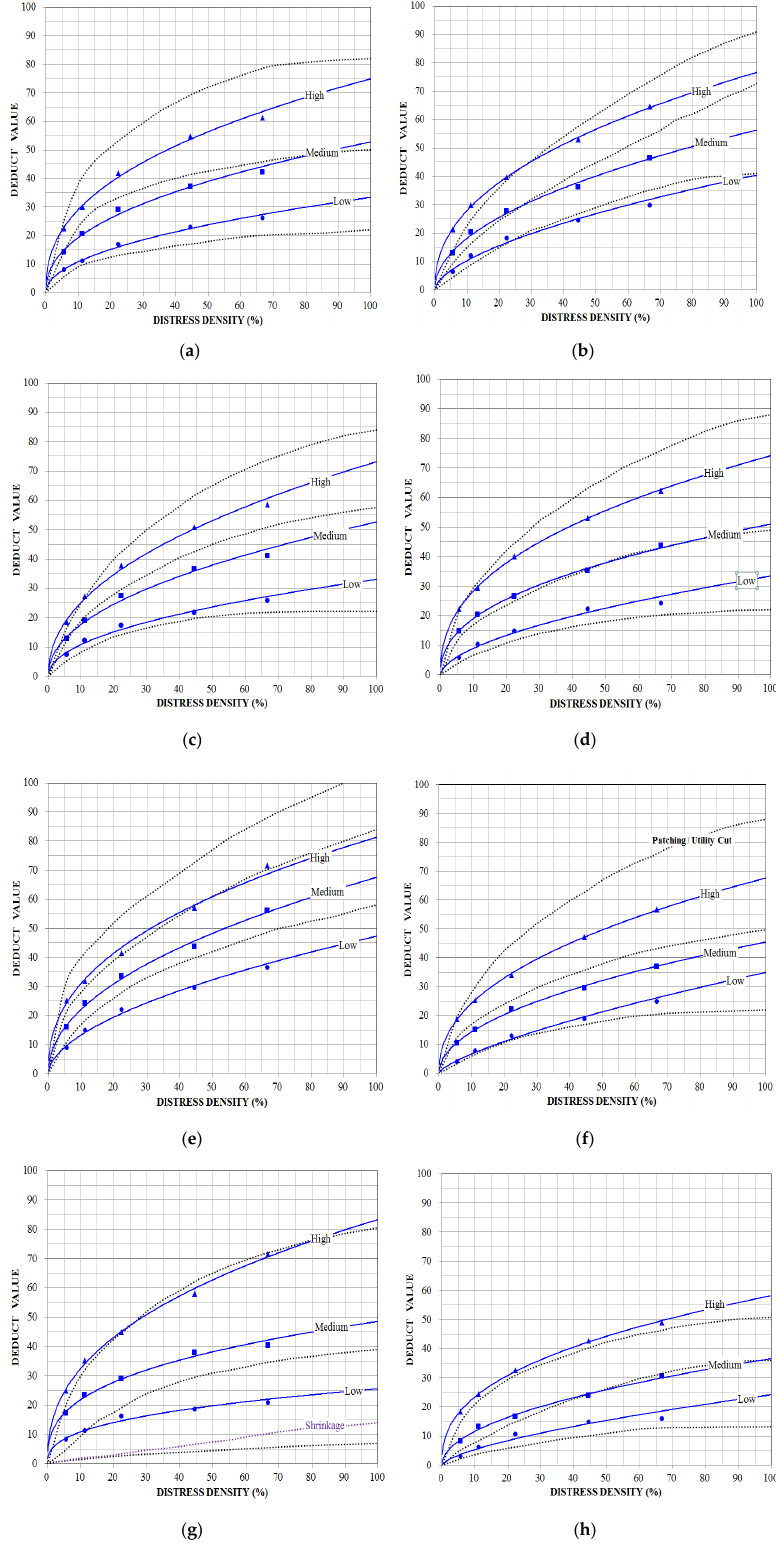
Figure 5. Comparisons between developed deduct value curves and ASTM D 5360 in concrete pavement; ( a ) Alkali Silica Reaction (ASR), ( b ) corner cracking, ( c ) cracks; longitudinal, transverse, and diagonal, ( d ) durability (“D”) cracking, ( e ) intersecting cracks, ( f ) patching, small, large, and utility cuts, ( g ) scaling, map cracking, shrinkage cracking, ( h ) spalling (longitudinal and transverse joint, and corner).